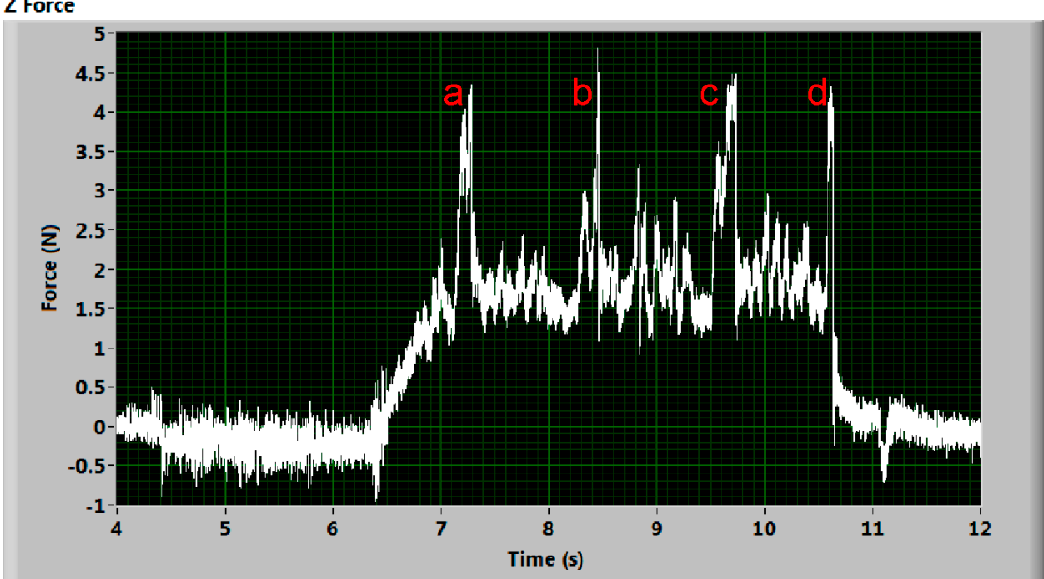
Figure 7. Deformation force signal with presumed uncut parts—normal force increases on the uncut material parts (duralumin 2017, traverse speed 400 mm/min). Peaks (a, b, c, d) correspond with increase of deformation force on uncut parts (Figure 9), where jet rebounds.